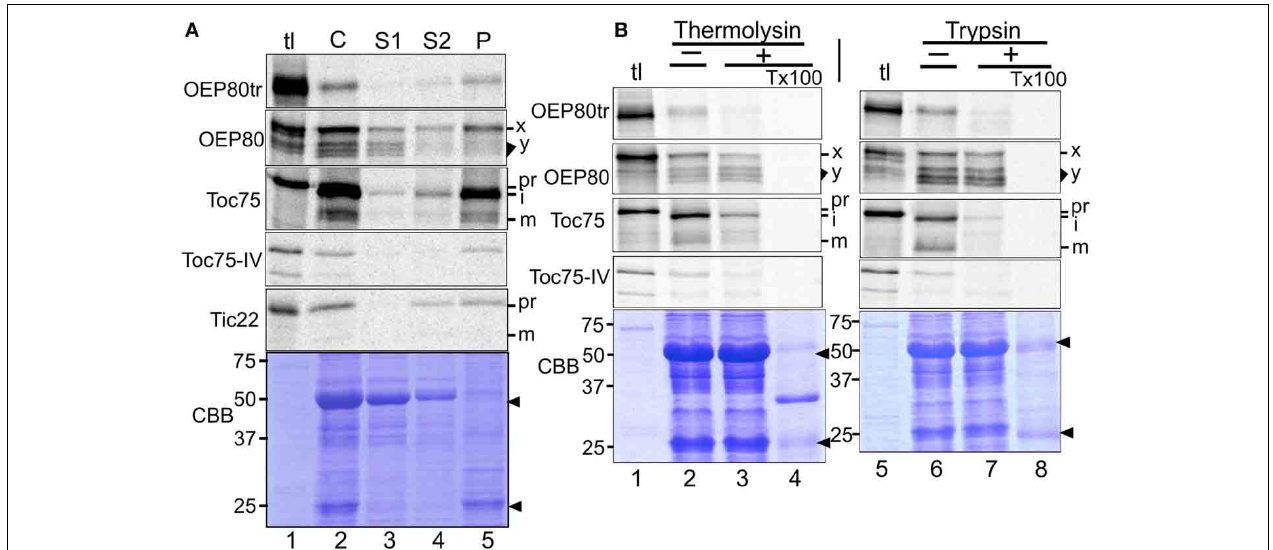
FIGURE 4 | Import of chloroplast Omp85 homologs in vitro . (A) Chloroplasts isolated from pea seedlings were incubated with radiolabeled proteins indicated at left in the import condition for 10min in the light. After the reaction, chloroplasts were re-isolated and divided into two samples. The first sample was loaded directly on SDS-PAGE (C). The second sample was lysed hypotonically and separated into supernatant (S1) and pellet fractions by centrifugation. The pellet fraction was further resuspended into 0.1M Na 2 CO 3 and separated into the supernatant (S2) and pellet (P) fractions by another centrifugation. The obtained S1, S2, and P fractions contained soluble, peripheral membrane, and integral membrane proteins, respectively. Radiolabeled proteins recovered in each fraction were separated by SDS-PAGE and visualized by phosphorimager analysis. Each lane was loaded with the sample equal to chloroplasts containing 3 μ g chlorophylls used for the import assay, and tl was loaded with 10% of the translation products equivalent to those used for the import assay containing 3 μ g chlorophyll-equivalent chloroplasts. For OEP80, the 74-kD OEP80 precursor, and the 66–71kD import products are